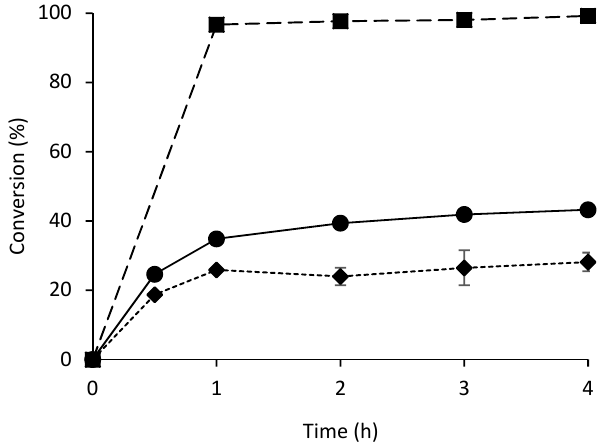
Figure 1. Synthesis of ( R )-mandelonitrile using di ff erent enzyme loadings. Immobilization was performed by incubating enzyme and carrier in an orbital shaker and subsequent drying. Dashed line and squares (20 U mg − 1 , final ee = 99%), solid line and dots (10 U mg − 1 , final ee = 63%) and dotted line and diamonds (5 U mg − 1 , final ee = 23%). Conditions: Ratio benzaldehyde:HCN in citrate / phosphate bu ff ered MTBE, pH 5, 1:4, benzaldehyde (100 µ L, 1 mmol), 2 mL HCN solution in citrate / phosphate bu ff ered MTBE (1.5–2 M) pH 5, 27.5 µ L (0.1 mmol) 1,3,5-triisopropylbenzene as internal standard (I.S.) and a teabag filled with At HNL immobilized on 60 mg EziG Opal. The reaction was stirred at 900 rpm at room temperature. Error bars correspond to the standard deviation of duplicates ( n = 2) HPLC samples of the single